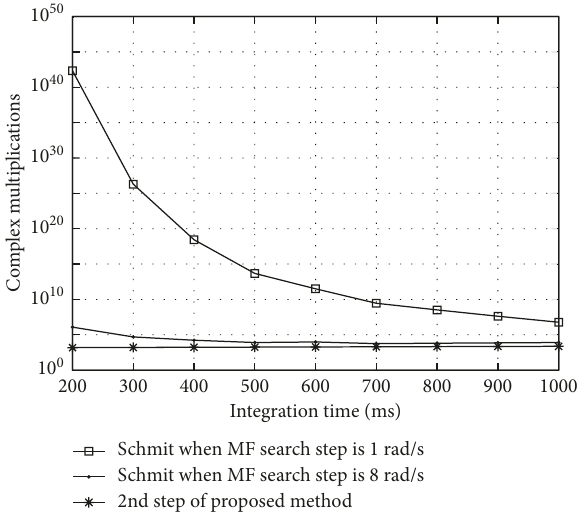
Figure 5: Complex multiplications comparison for fine MF esti- mation methods.